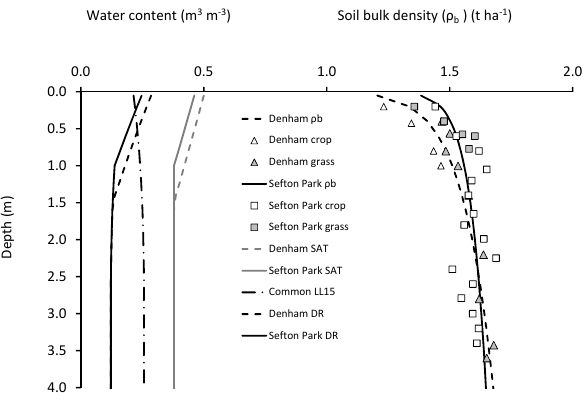
Fig. 2. Measured soil bulk density ( ρ b ) and water holding capacity at “perennial vegetation lower limit” assumed= − 15bar (LL15) and derived water holding capacity at saturation (SAT) and drainable water capacity